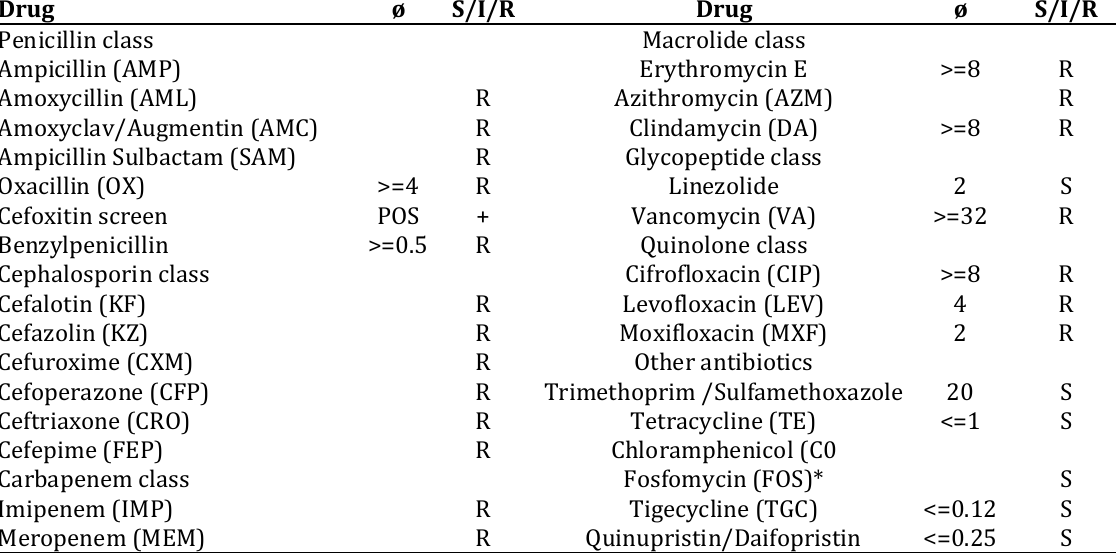
Table I. Source of Methicillin Resistance Staphylococcus aureus (MRSA). Sample number: 201908017267 (155C); Check date: August 6, 2019; Approval date: 9 August 2019; Material: Wipe the wound; Culture results: Staphylococcus